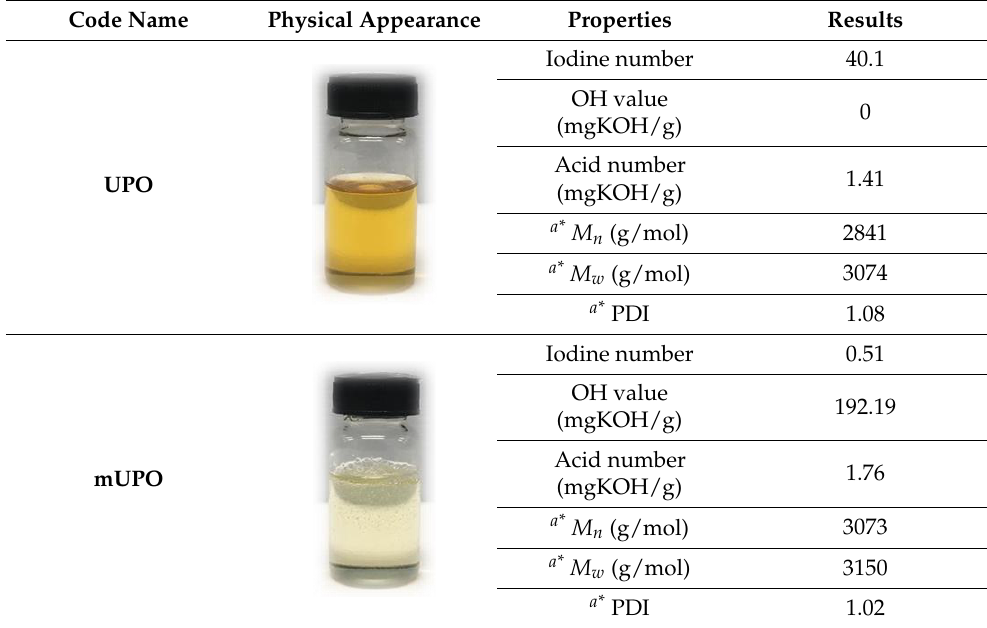
Figure 1. The modification process and chemical structure of UPO and mUPO. Table 2. Summary of properties of UPO and mUPO.